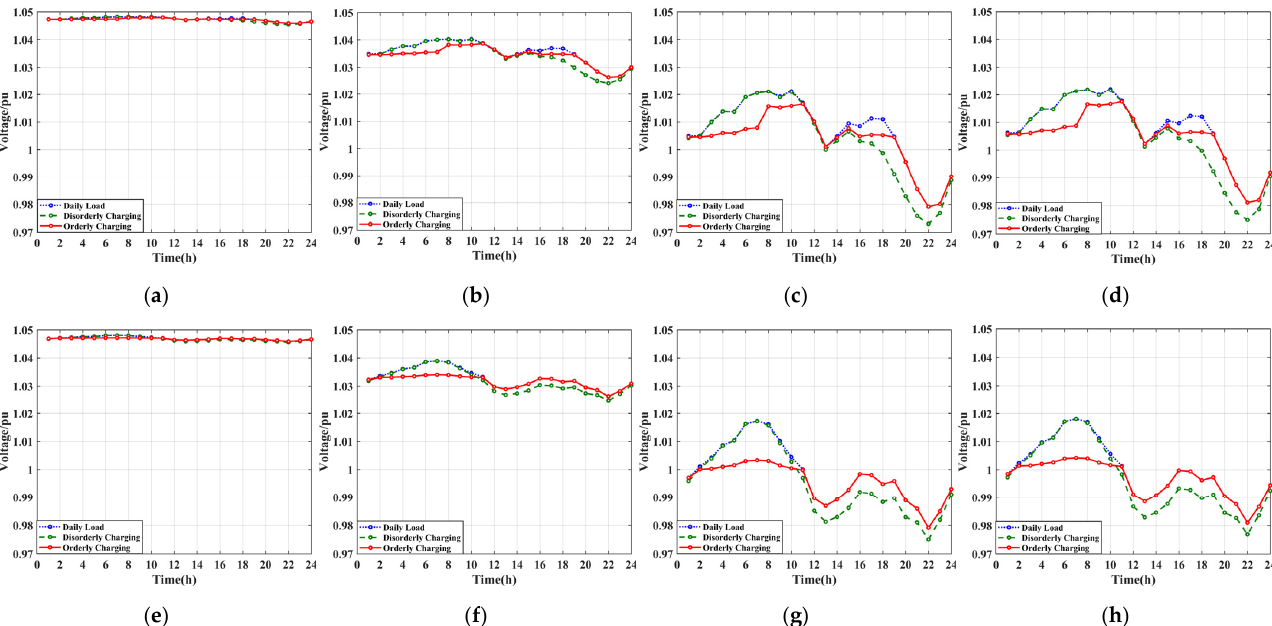
Figure 7. The voltage of the EV access nodes. ( a ) Node 2 (weekday), ( b ) Node 3 (weekday), ( c ) Node 7 (weekday), ( d ) Node